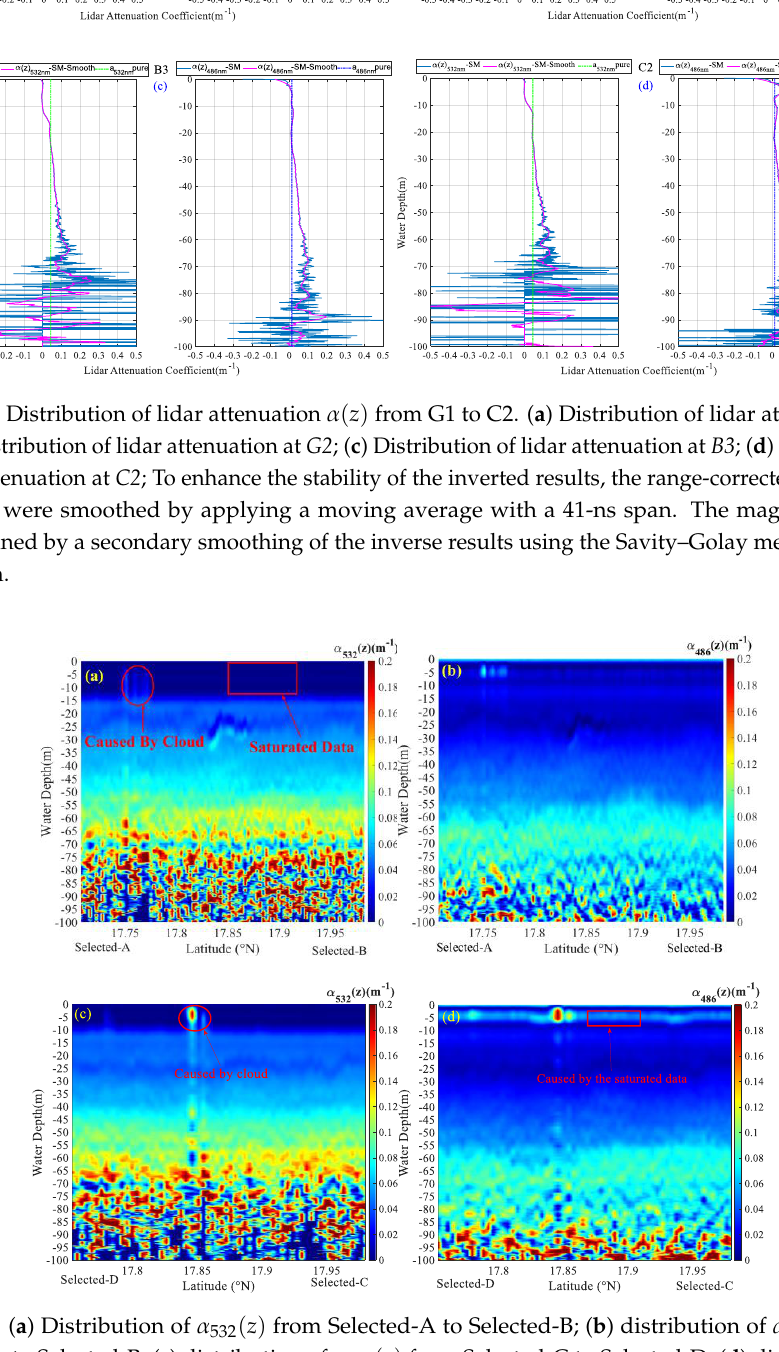
( ) z  and ( ) z  over the flight track 532 486